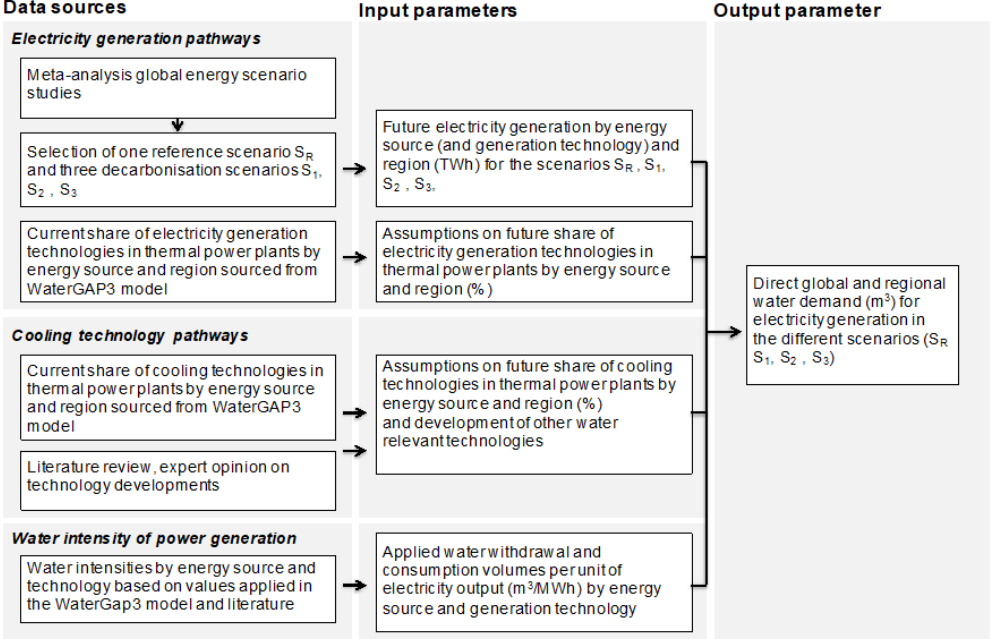
Figure 1. Overview of the methodology applied to estimate water demand for di ff erent electricity generation pathways. S R = Reference electricity generation scenario, S 1–3 = decarbonization electricity generation scenarios to be